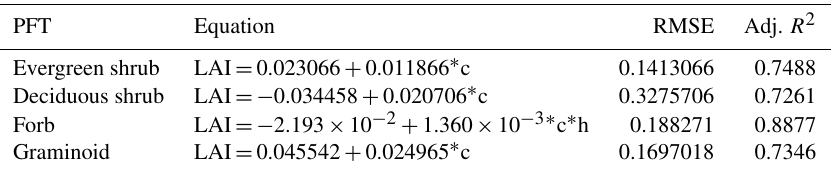
Table A1. Equations for calculating the leaf area index (LAI) for four plant functional types (PFTs) based on percentage cover (c;%) and height (h; cm)